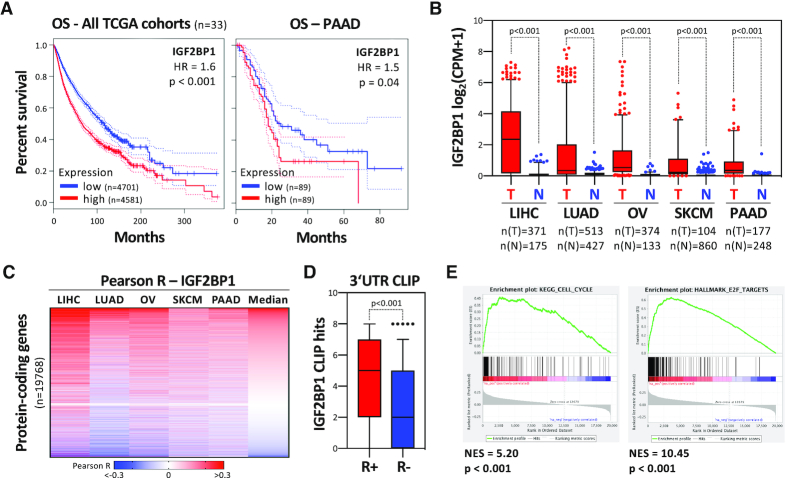
IGF2BP1 is a conserved pro-oncogenic RBP in human cancer. (A) Kaplan–Meier plots of overall survival analyses (median cutoff) based on IGF2BP1 mRNA expression. Overall survival was analyzed for all TCGA (The Cancer Genome Atlas) tumor cohorts (9282 patients, left) and the PAAD cohort (Pancreatic Adenocarcinoma, 178 patients, right). Red, high expression of IGF2BP1; Blue, low expression of IGF2BP1. HR, hazard ratio; p, logrank p value. (B) Box plots showing the IGF2BP1 expression in tumor and normal tissues for indicated cancers. Data were derived from the TCGA (T, red boxes) and GTEx (N, blue boxes) portal. The number (n) of analyzed samples is indicated. LIHC, liver hepatocellular carcinoma; LUAD, lung adenocarcinoma; OV, ovarian carcinoma; SKCM, skin cutaneous melanoma; PAAD, pancreatic adenocarcinoma). (C) Heatmap of correlation coefficients (R) determined for protein-coding gene and IGF2BP1 expression. R values were determined in indicated TCGA data sets and ranked according to median correlation coefficient. Scale bar in lower panel. (D) Box plots of experiments indicating IGF2BP1 CLIP hits in the 3′UTR of mRNAs showing positive (R+; R > 0.15, n = 2039) or negative (R–; R←0.15, n = 155) association with IGF2BP1 expression in cancers analyzed in (C). (E) Gene set enrichment analysis (GSEA) of IGF2BP1-correlated gene expression in the five cancers analyzed in (C). GSEA was performed on ranked median correlation coefficient determined in (C). KEGG pathway ‘Cell Cycle’ (left) and the Hallmark pathway ‘E2F Targets’ (right) are shown. NES, normalized enrichment score. Statistical significance was determined by Mann–Whitney test.